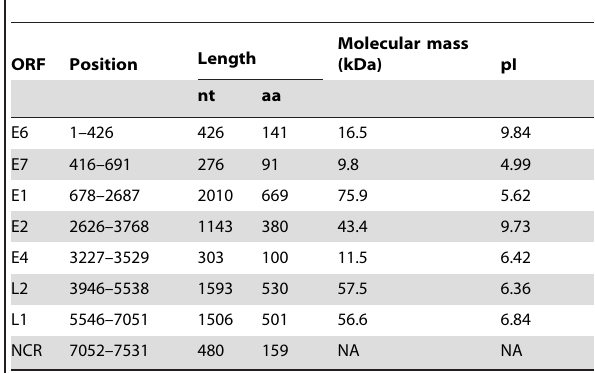
Table 1. Size and position of predicted ORFs and NCR of MscPV1 and the predicted molecular masses of the translated